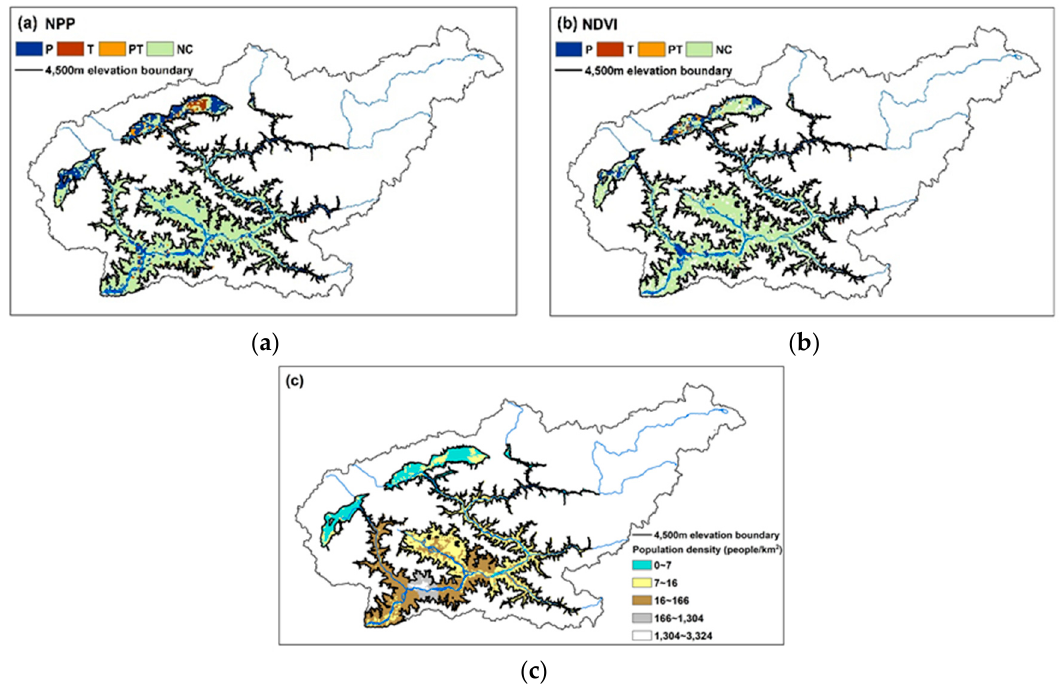
Figure 6. The vegetation dynamics driving factors: ( a ) driving factors of NPP; ( b ) driving factors of NDVI, and ( c ) population density below 4500 m in the Lhasa River Basin